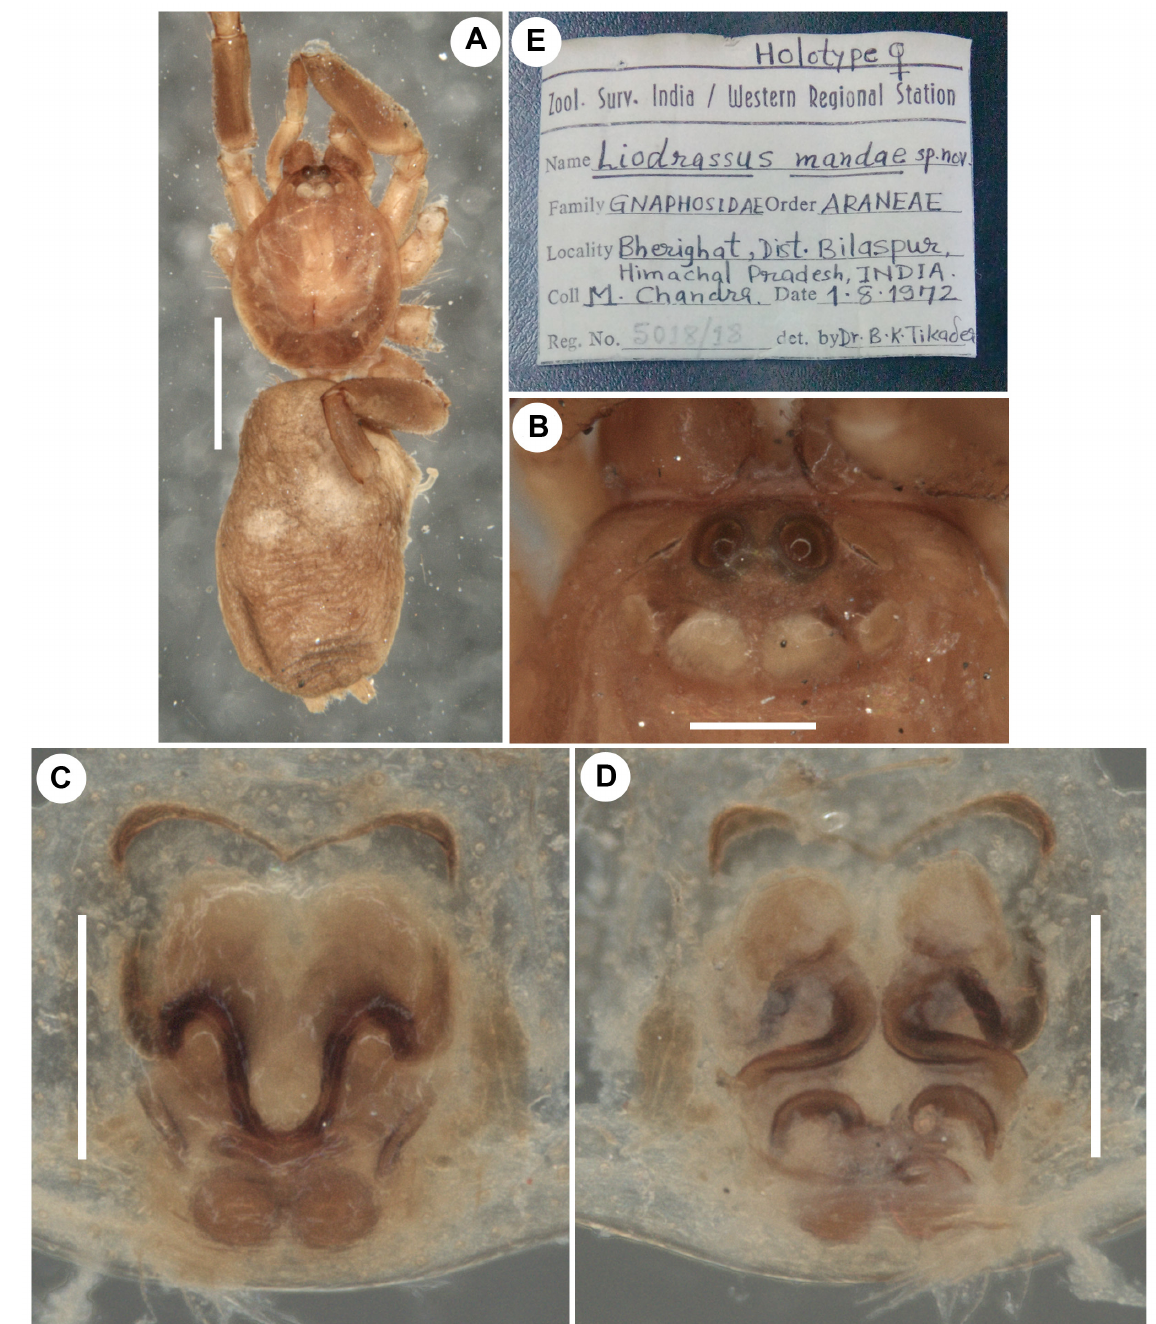
Fig. 6. Setaphis browni (Tucker, 1923), ♀, holotype of Liodrassus mandae Tikader & Gajbe, 1977 (NZC-ZSI-5018/18). A . Habitus, dorsal view. B . Eyes of the same, dorsal view. C . Epigyne, ventral view. D . Same, dorsal view. E . Label from type bottle. Scale bars: A = 1 mm; B–D = 0.2